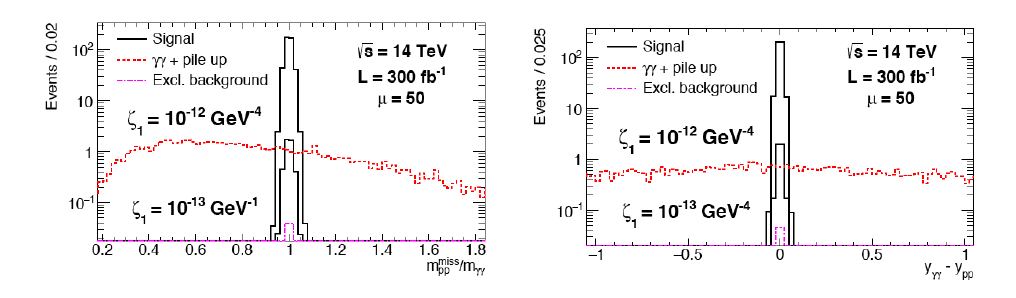
Figure 5: Mass ratio and rapidity difference between the pp and γγ information for signal (in full line) and pile up background (dashed